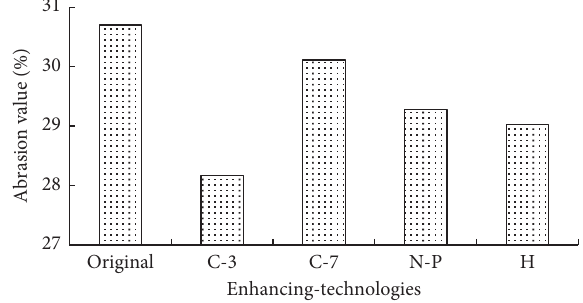
Figure 7: Abrasion value of RA before and after chemical en-